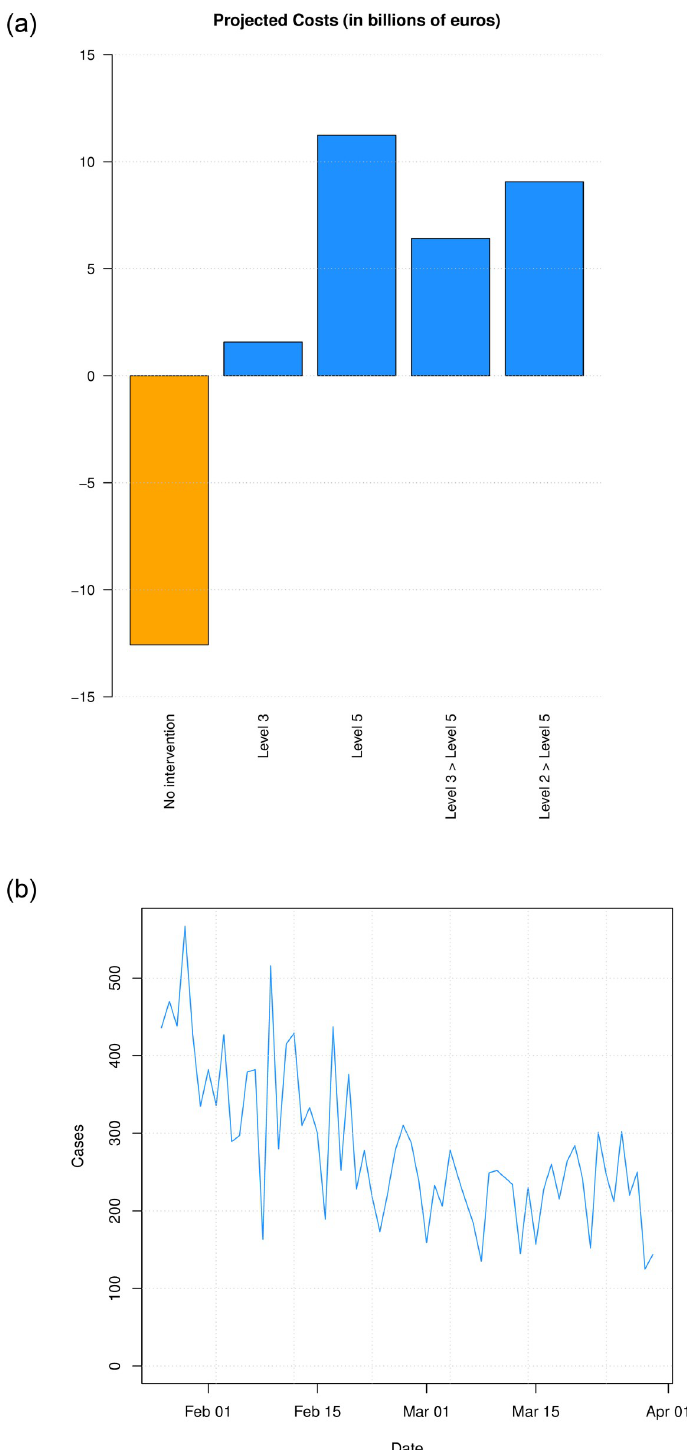
Fig 9. Left: Estimated economic costs for the 8 week period between 1st February 2021 and 30th March 2021. Right: Time series of actual daily cases for 8 week period between 1st February 2021 and 30th March 2021.